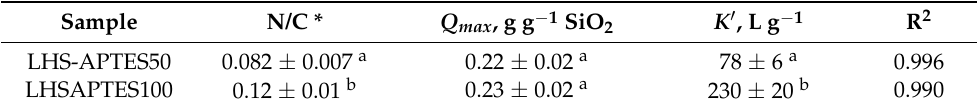
Table 2. Sorption parameters of LHS-APTES polyelectrolyte complexes with different reagent ratio on silica gel fitted to the shifted squared modified Langmuir model (SSLM) (0.03 M phosphate buffer, pH 6.0, 24 h, 20 °C). Sample